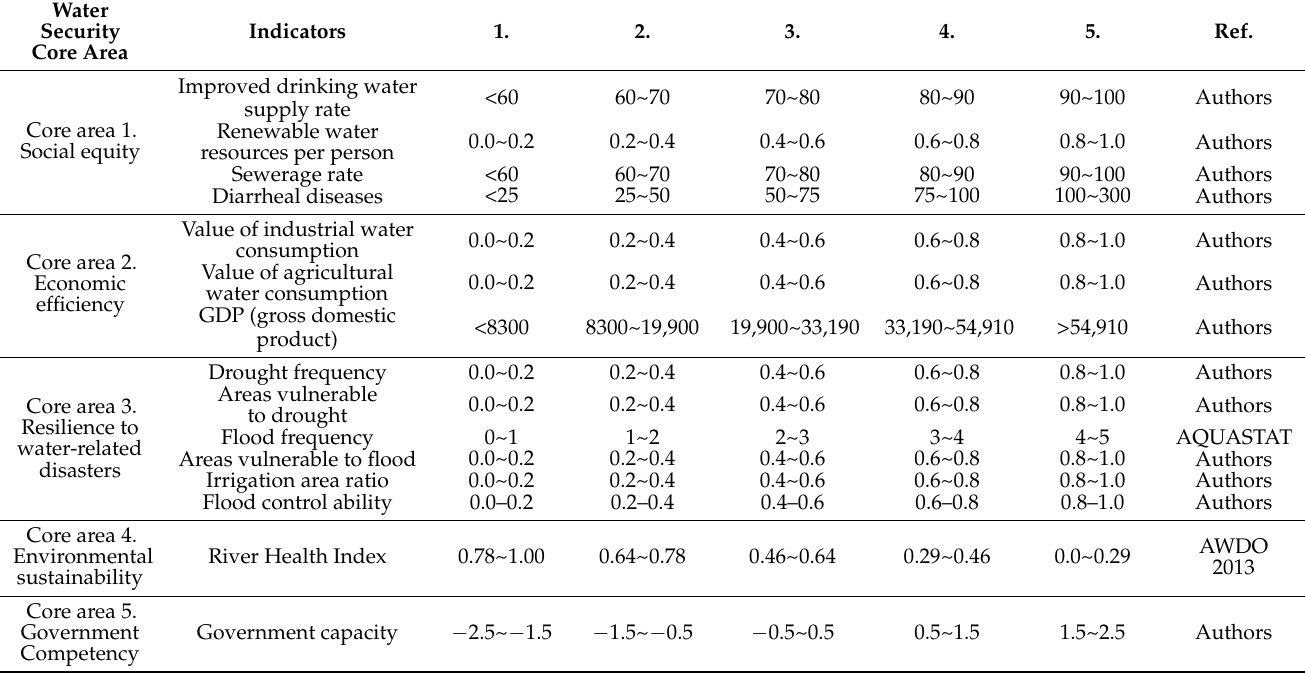
Table 6. Thresholds of each class for water security